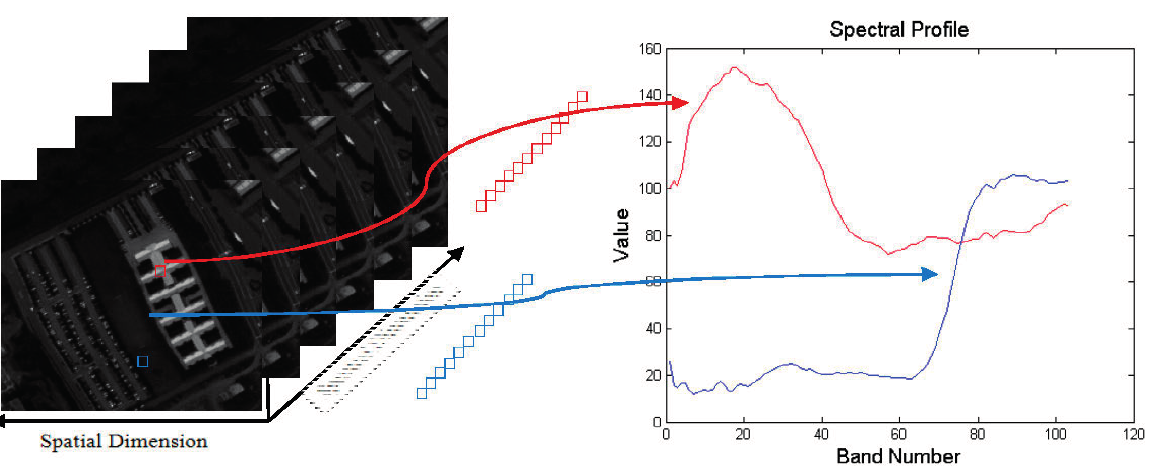
Figure 2. Schematic view of the HSI data. Left: A three dimensional HSI data. Right: Reflected spectral curve at the corresponding pixels of each band in the